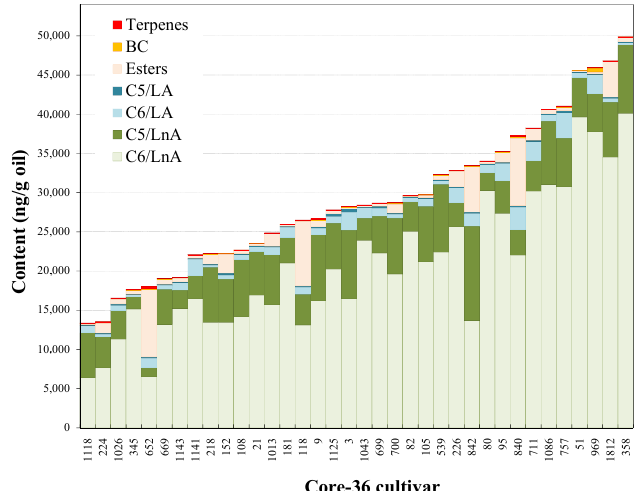
Figure 1. Content of the main groups of volatile compounds in the oils of the Core ‐ 36. Fruits at the turning stage were hand ‐ picked during years 2008–2012.